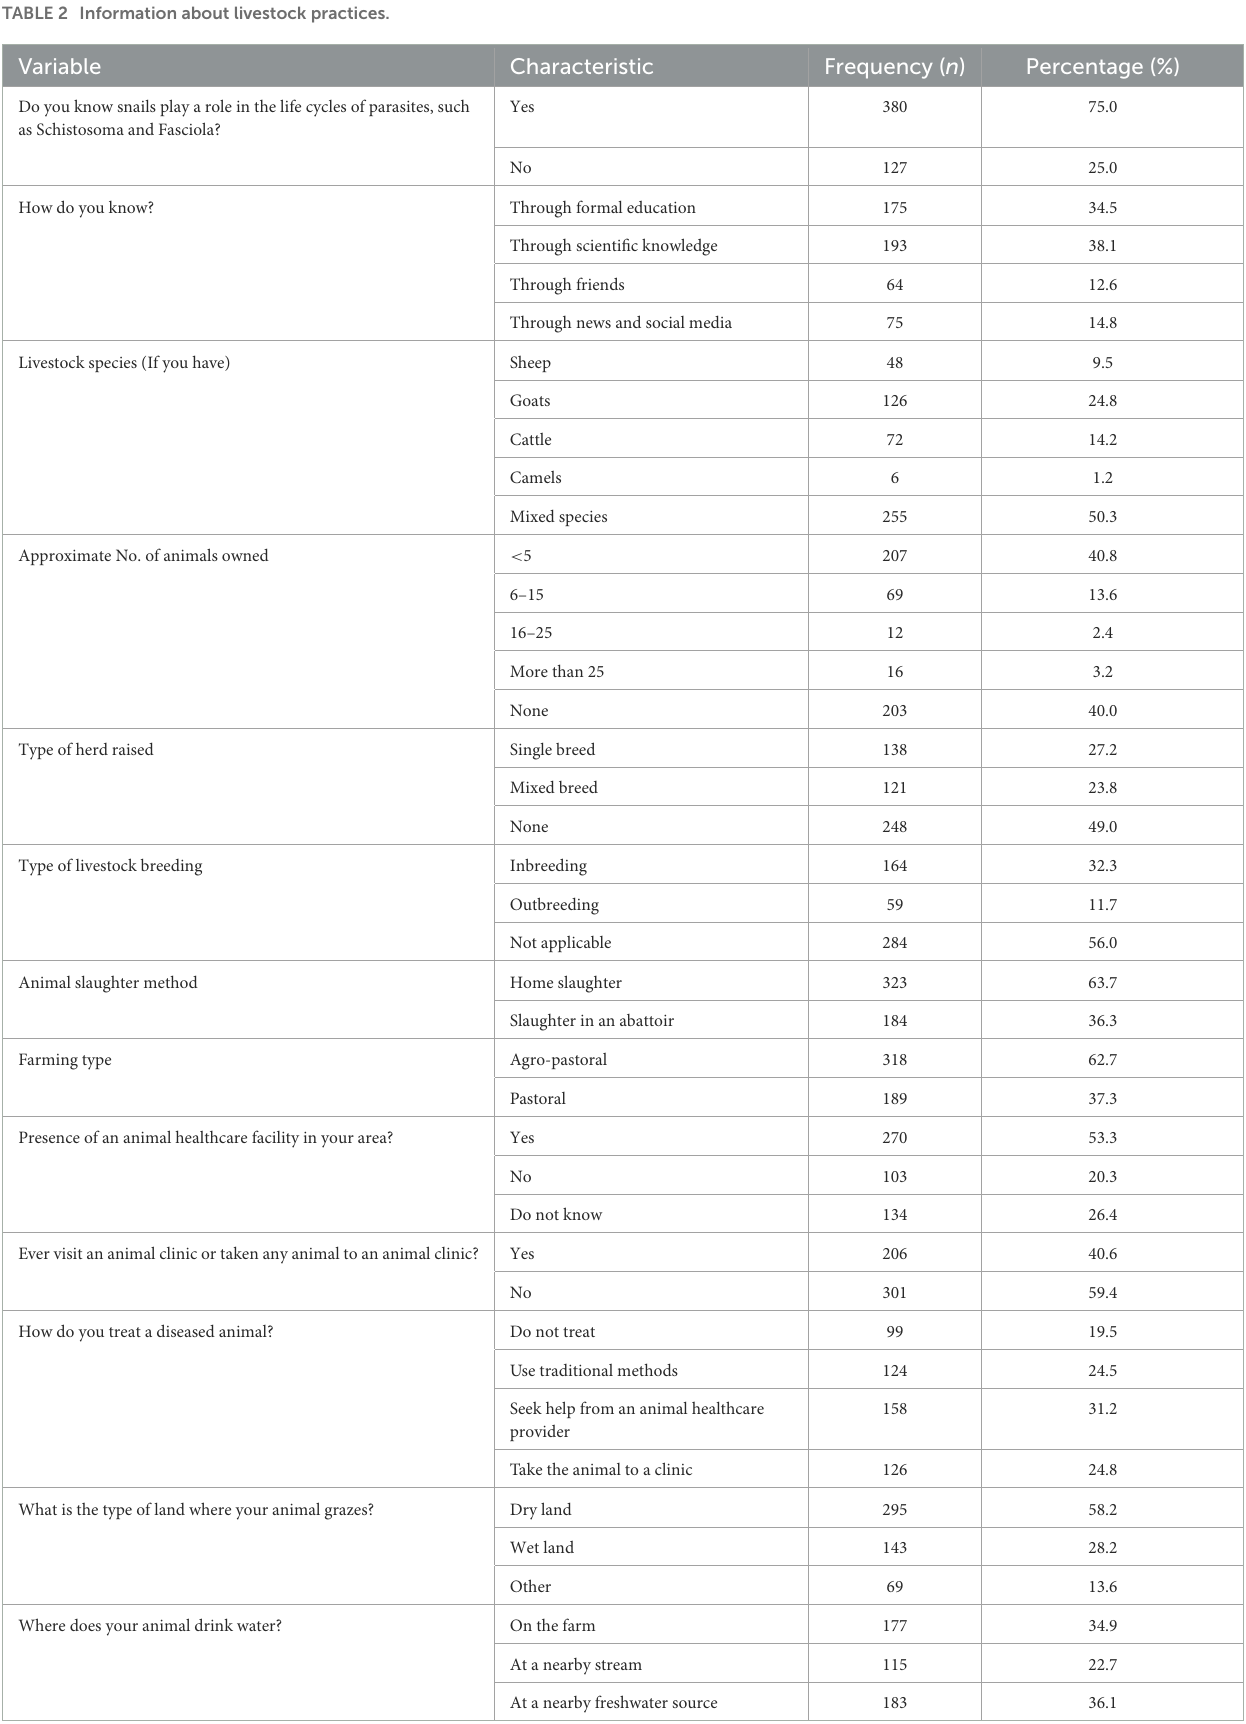
TABLE 2 Information about livestock